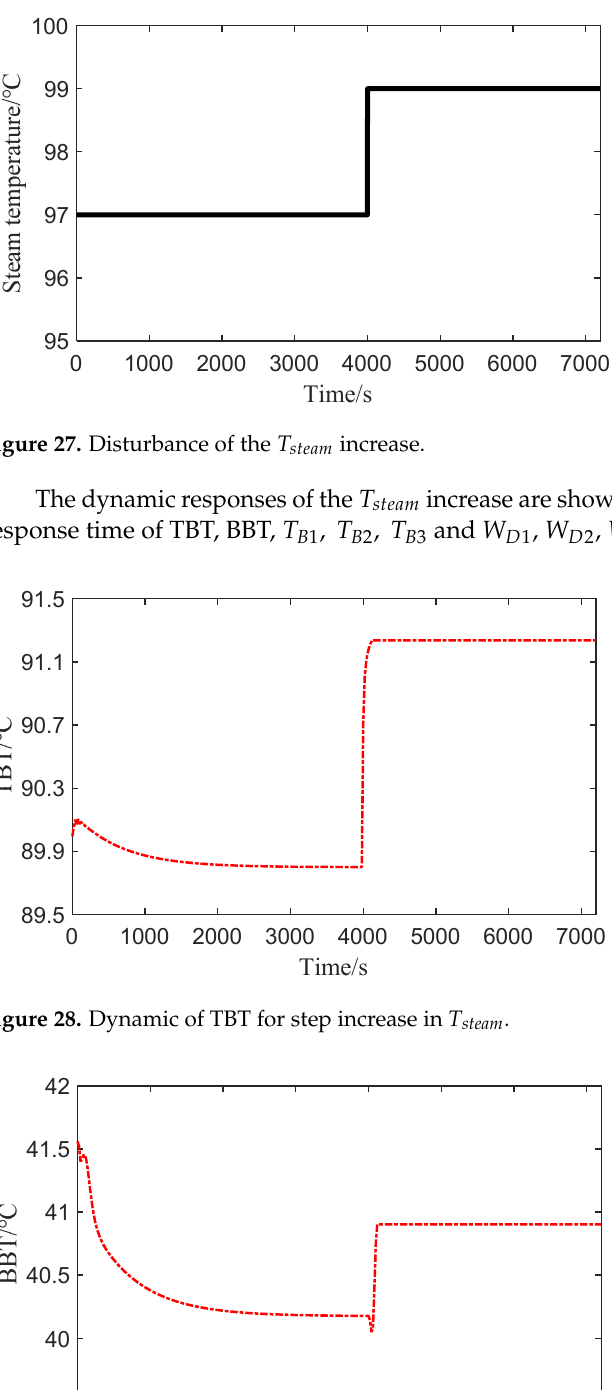
Figure 28. Dynamic of TBT for step increase in .